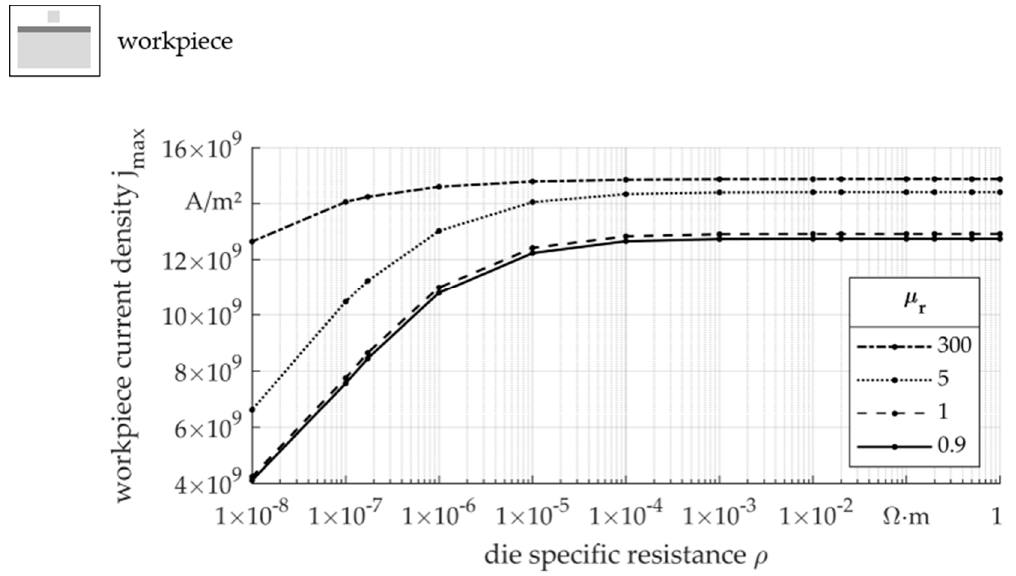
Figure 7. Maximum current density j max in the workpiece volume in respect of the specific resistance 𝜌 of the die material.